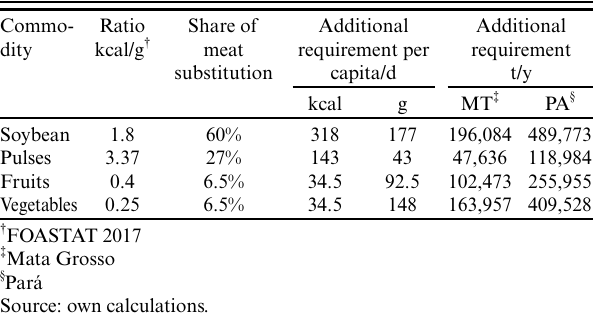
Table 3 . Quantities of commodities replacing animal product